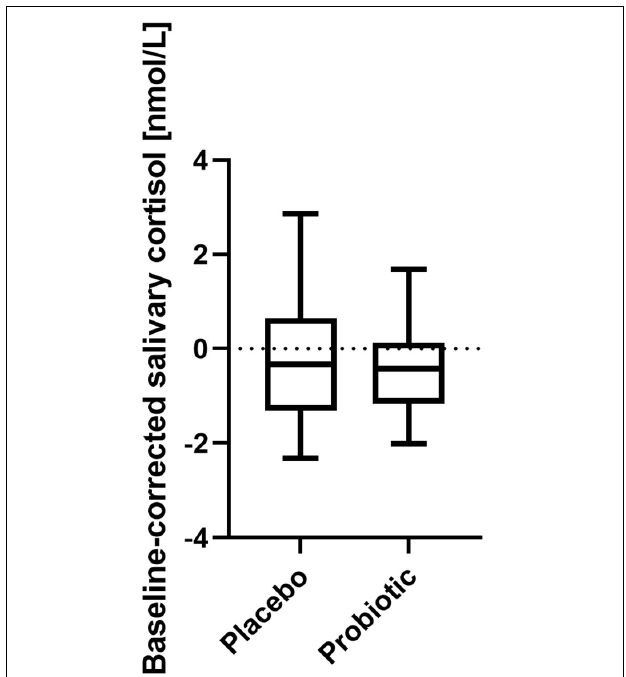
FIGURE 4 | Baseline-corrected salivary cortisol concentrations after EAT after placebo and probiotic intervention. No statistically significant differences were found between both interventions. Line presents median, box presents 25th and 75th percentile, whiskers present minimum to maximum; paired t -test; n = 21. EAT, emotional attention